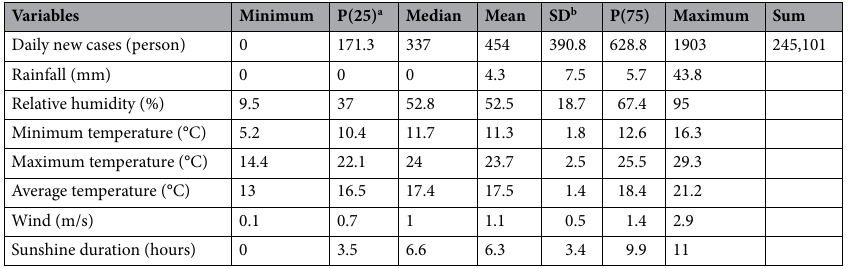
Table 1. Summary statistics of daily confirmed Covid-19 new cases and climate variables in Addis Ababa (N = 540). Data source: from 10th May 2020 to 31st October 2021. a Percentile and b Standard